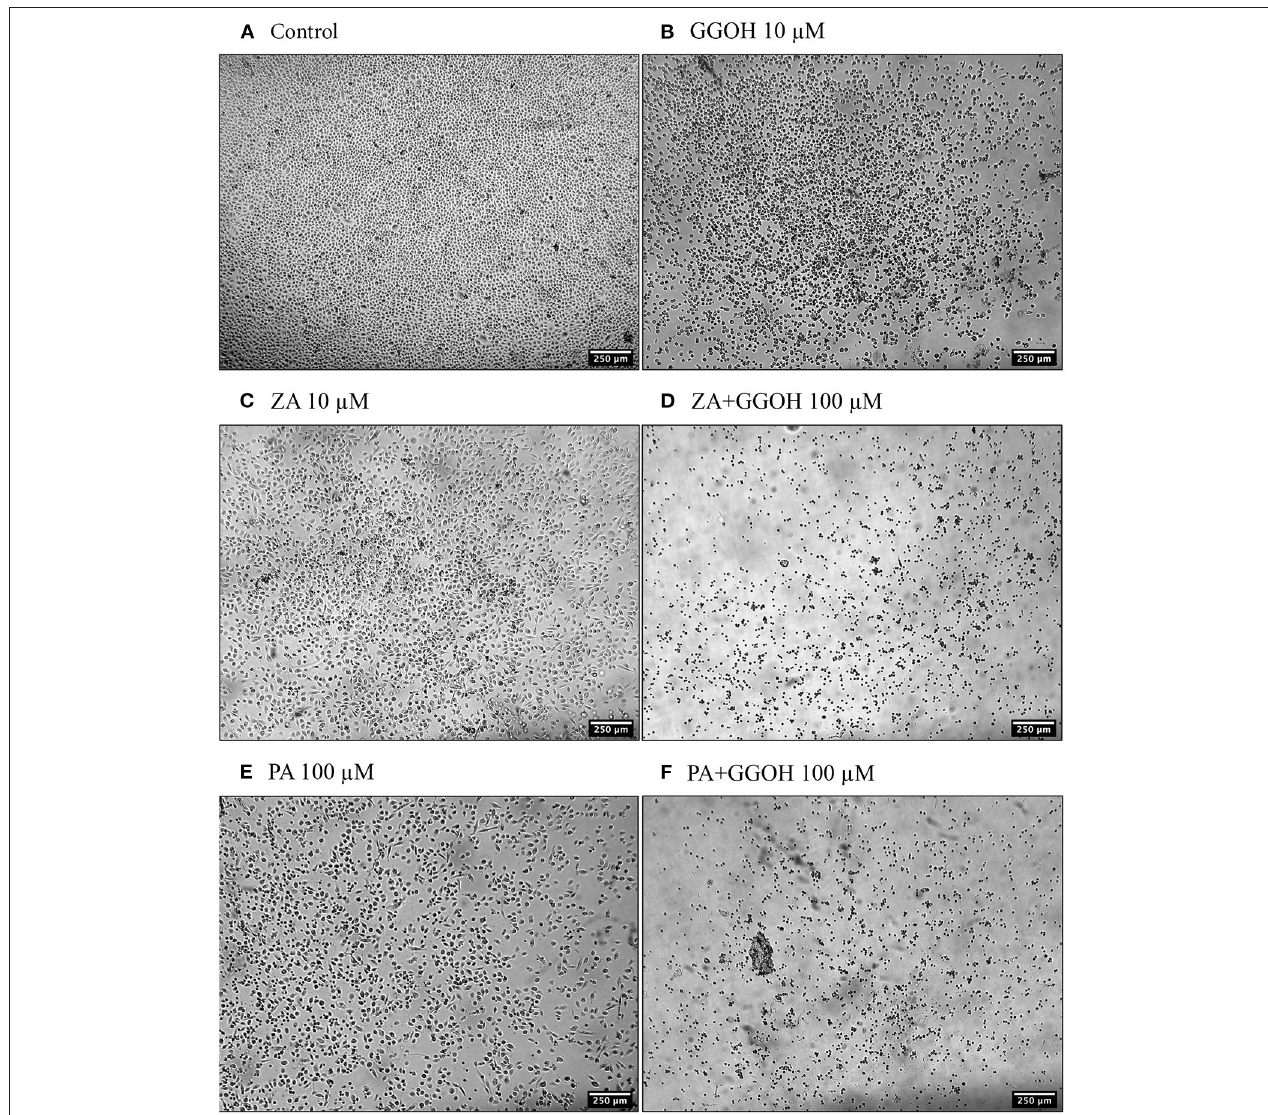
FIGURE 4 | The morphology of oral keratinocytes after 72h of treatment (A) Control (B) GGOH 10 µ M (C) ZA 10 µ M (D) ZA+GGOH 100 µ M (E) PA 100 µ M (F) PA+GGOH 100 µ M. Magnification of 4 × from a light inverted